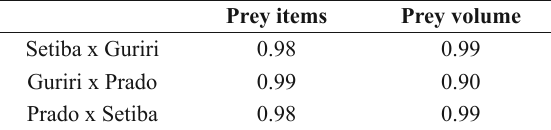
Diet niche overlap for Phyllodytes luteolus in three remnants of restinga along the Brazilian coast based on proportional values of prey items and prey